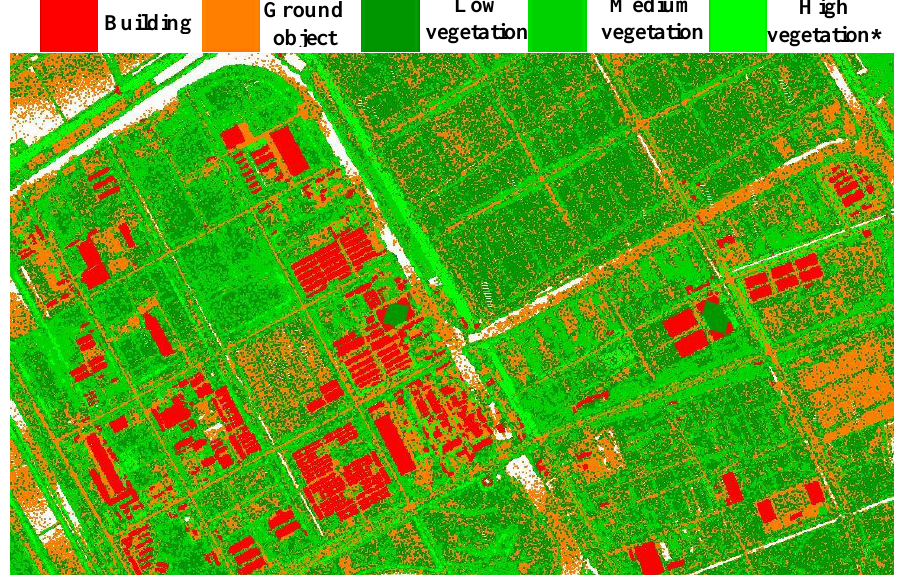
Figure 2. Classification of wetland vegetation derived from LiDAR point cloud data. * High vegetation: